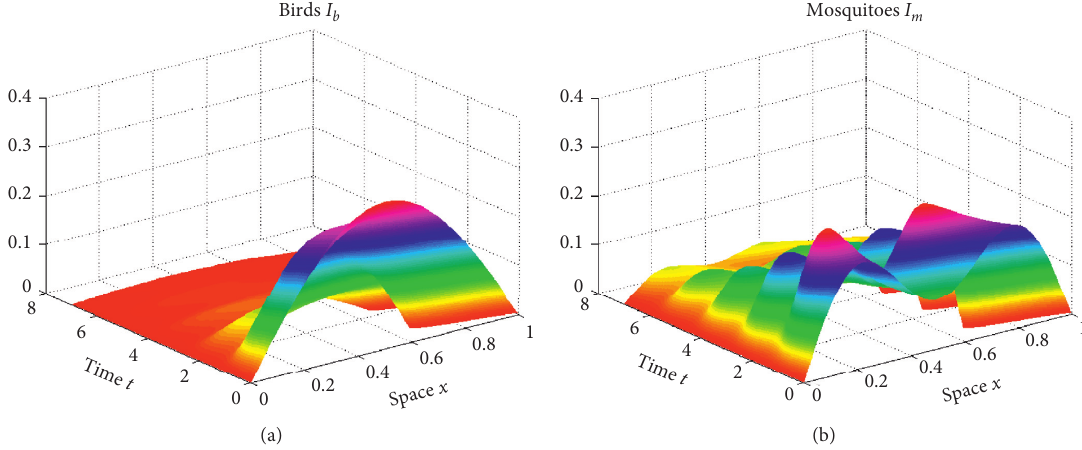
Figure 7: ρ ( t ) � e 0 . 2 ( cos ( 4 t )− 1 ) . ρ − 2 > 1, R